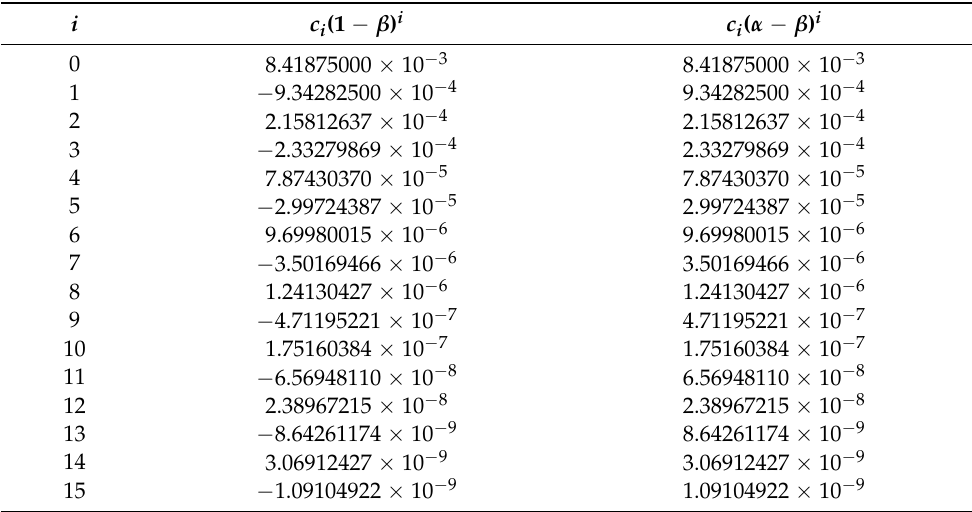
Table 2. Numerical values of c i (1 − β ) i and c i ( α − β ) i .